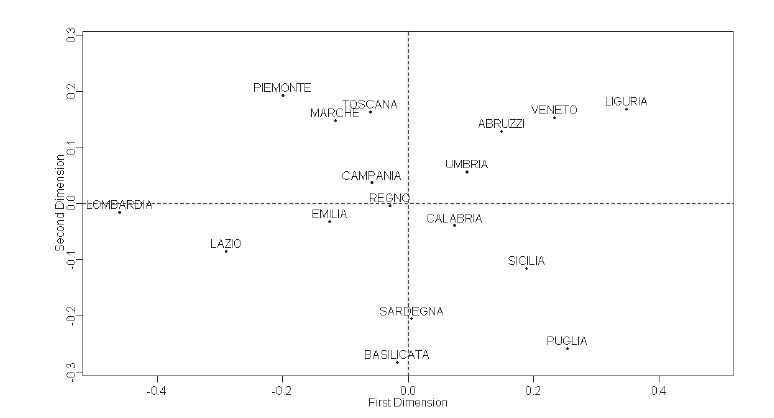
Figure 5 − Projections of the regions on the bivariate approximation of the